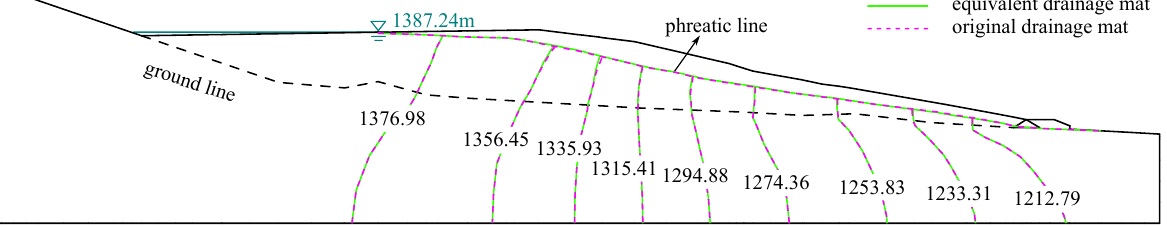
Figure 6. The water potential distributions in quasi-3d models for verification (m). The water potential distributions in the tailings dam with equivalent and original drainage structures are approximately identical when the permeability of equivalent drainage structure is 1.0 × 10 − 4